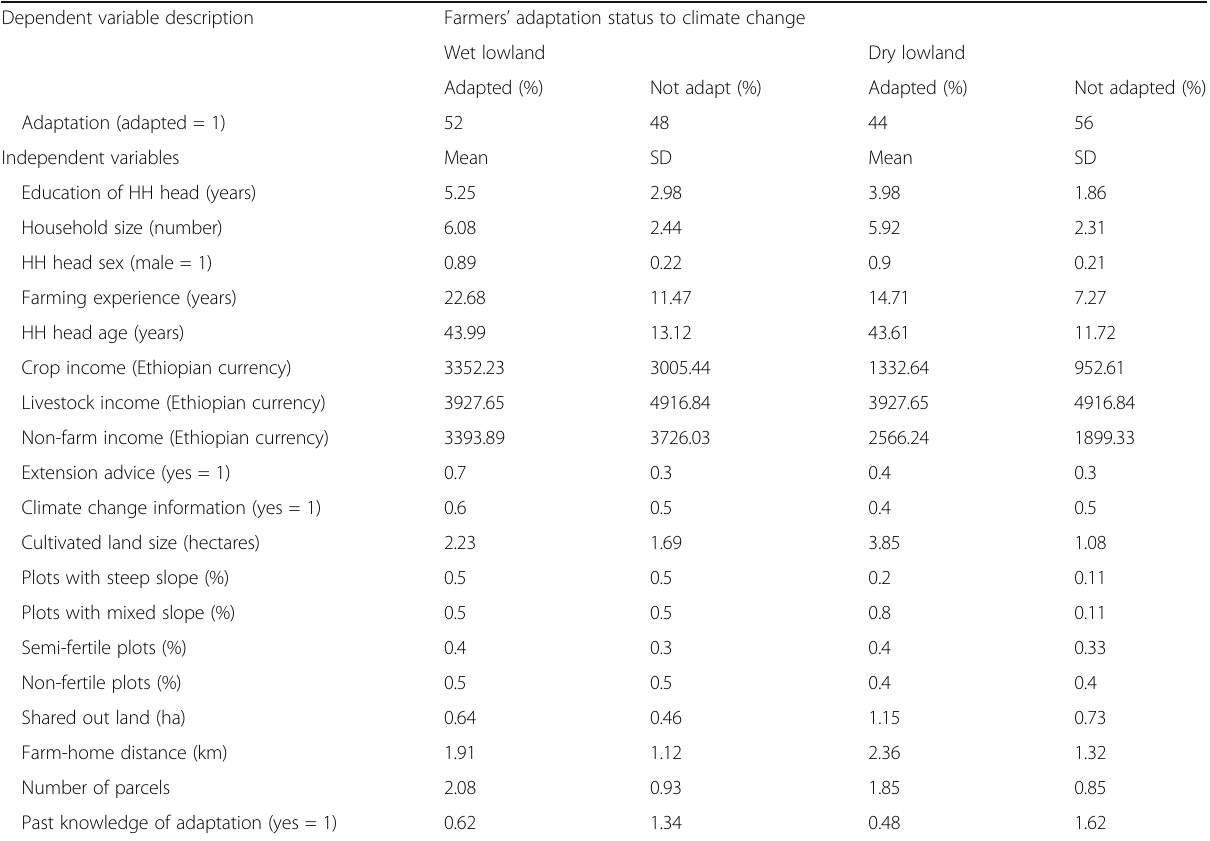
Table 7 Descriptive summary of model variables for Heckman probit outcome model Dependent variable